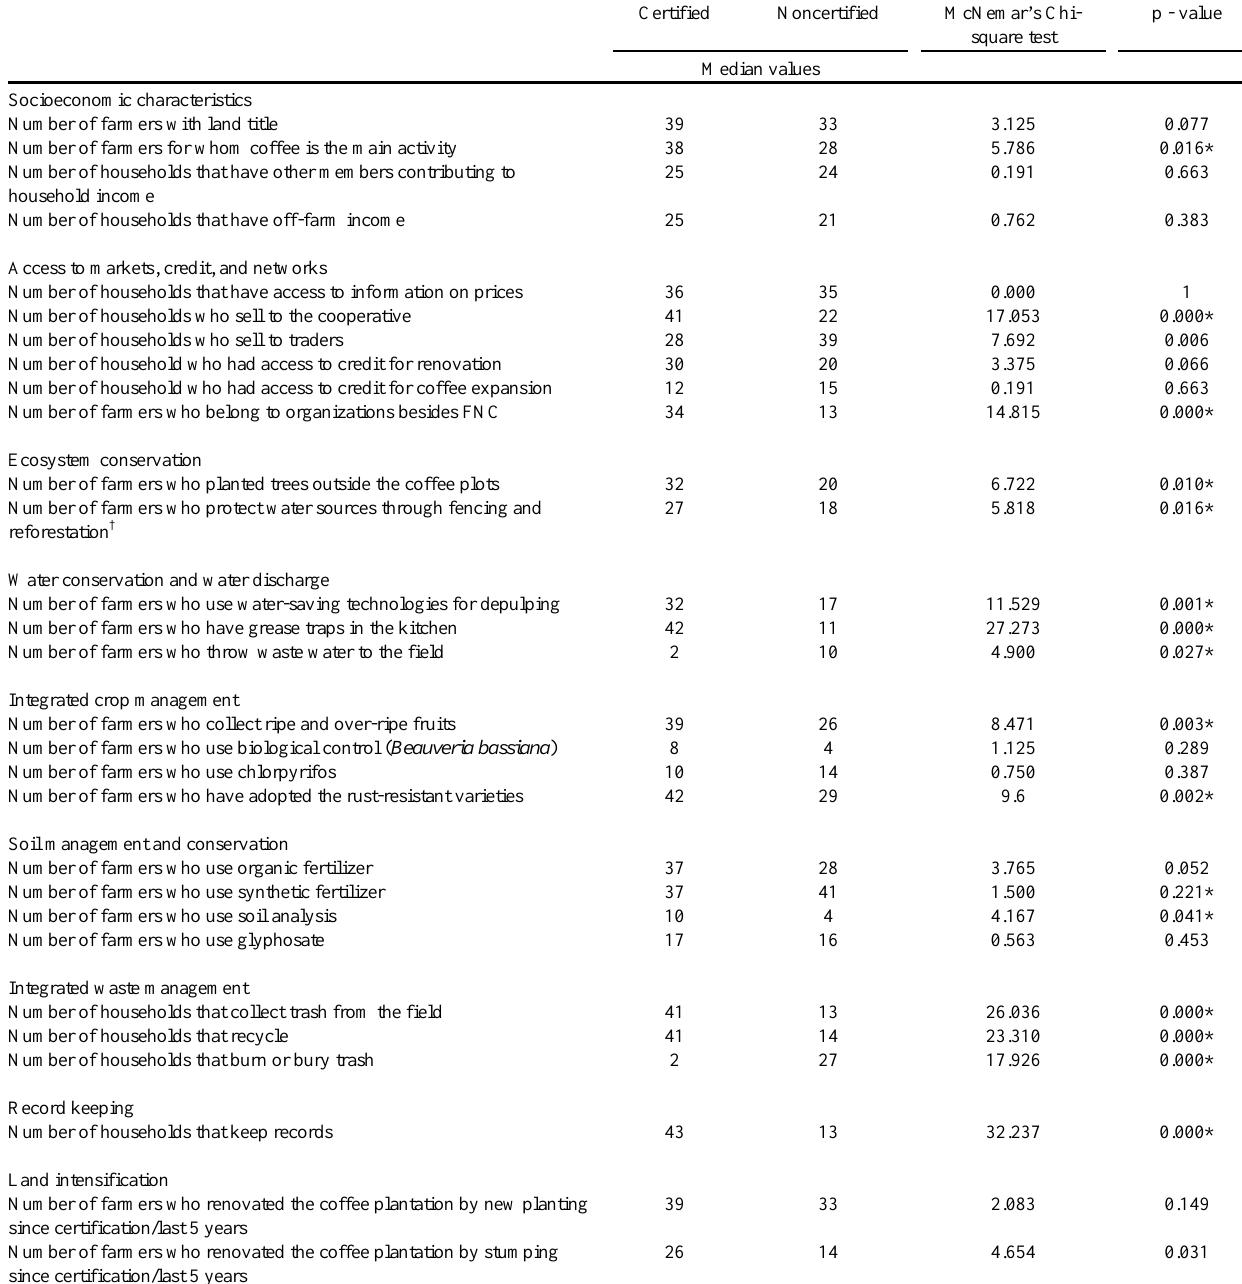
Table 2 . Difference in practices between certified and noncertified farms: dichotomous variables (n = 86).